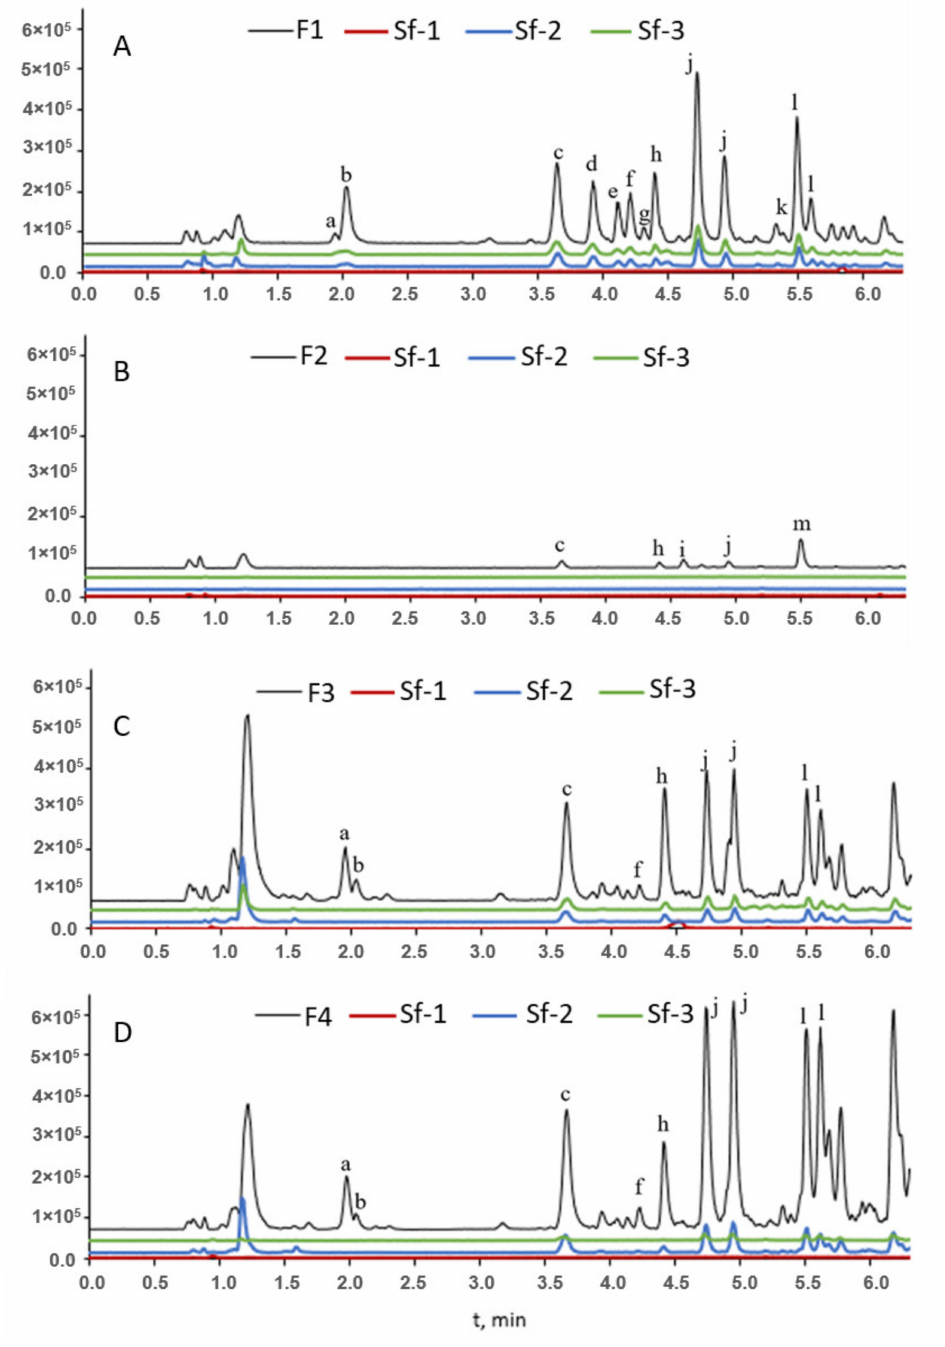
Figure 3. UHPLC-MS chromatograms of the waste stream fractions ( A – D ) and their subfractions. Identified structures in each peak: a—C 6 H 10 O 4 ; b—C 6 H 6 O 3 ; c—C 6 H 6 O 2 ; d—C 7 H 6 O 3 ; e—C 9 H 8 O 3 ; f—C 8 H 8 O 3 ; g—C 9 H 8 O 3 ; h—C 9 H 10 O 4 ; i—C 7 H 6 O 2 ; j—C 7 H 8 O 2 ; k—C 8 H 8 O 2 ; l—C 8 H 10 O 2 ; m—C 10 H 10 O 3